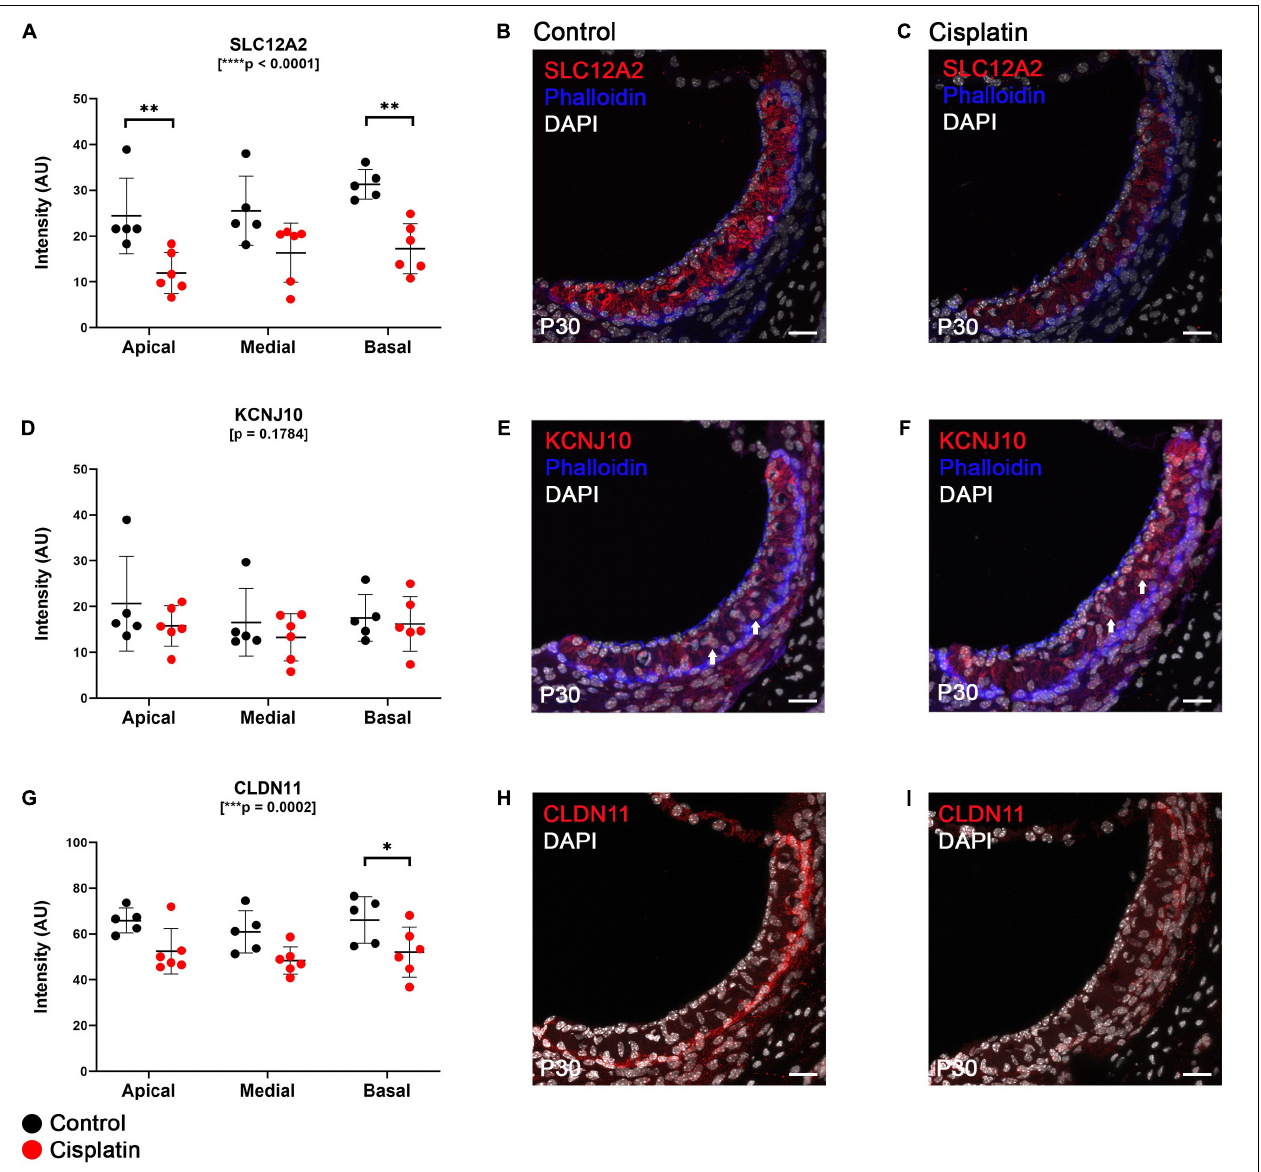
FIGURE 2 | Expression of key EP-related cell-type specific proteins is reduced in the SV after cisplatin treatment. (A) Twenty four hours after cisplatin injection, SLC12A2 immunofluorescence intensity was significantly reduced in the apical and basal turns of the cochlea (two-way ANOVA, p < 0.0001; Sidak’s multiple comparisons test, q = 0.0068 and q = 0.0022, respectively). (B,C) Representative SLC12A2 immunostaining of SV cross sections of control and cisplatin-treated mice. (D) Immunofluorescence staining intensity of KCNJ10 was unchanged between control and cisplatin-treated mice (two-way ANOVA, p = 0.1784). (E,F) Representative KCNJ10 immunostaining of SV cross sections of control and cisplatin-treated mice. White arrows point to representative intermediate cell nuclei. (G) Immunofluorescence staining intensity of CLDN11 was reduced in the basal turn of cisplatin-treated compared to control mice (two-way ANOVA, p =